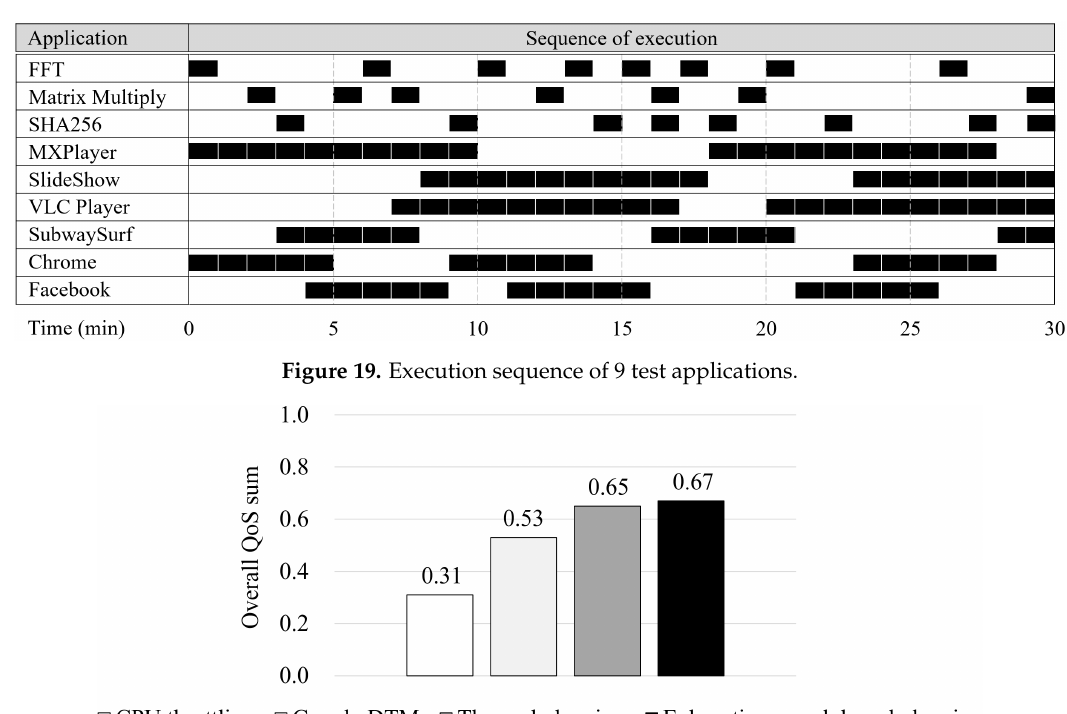
Figure 20. QoS comparison in a realistic NANS service